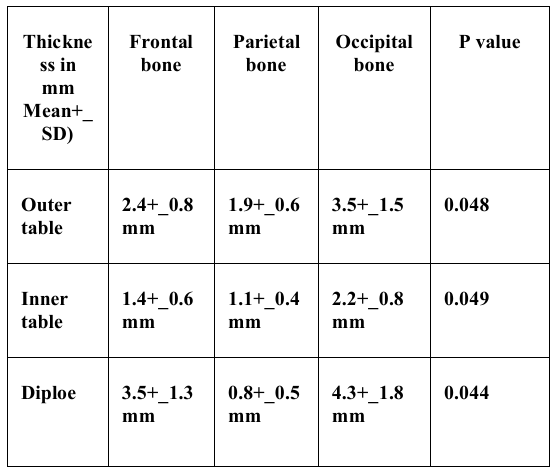
Table 2: Comparison of mean thickness of outer table, inner table and diploe of Frontal, Parietal and Occipital bones (n=150).